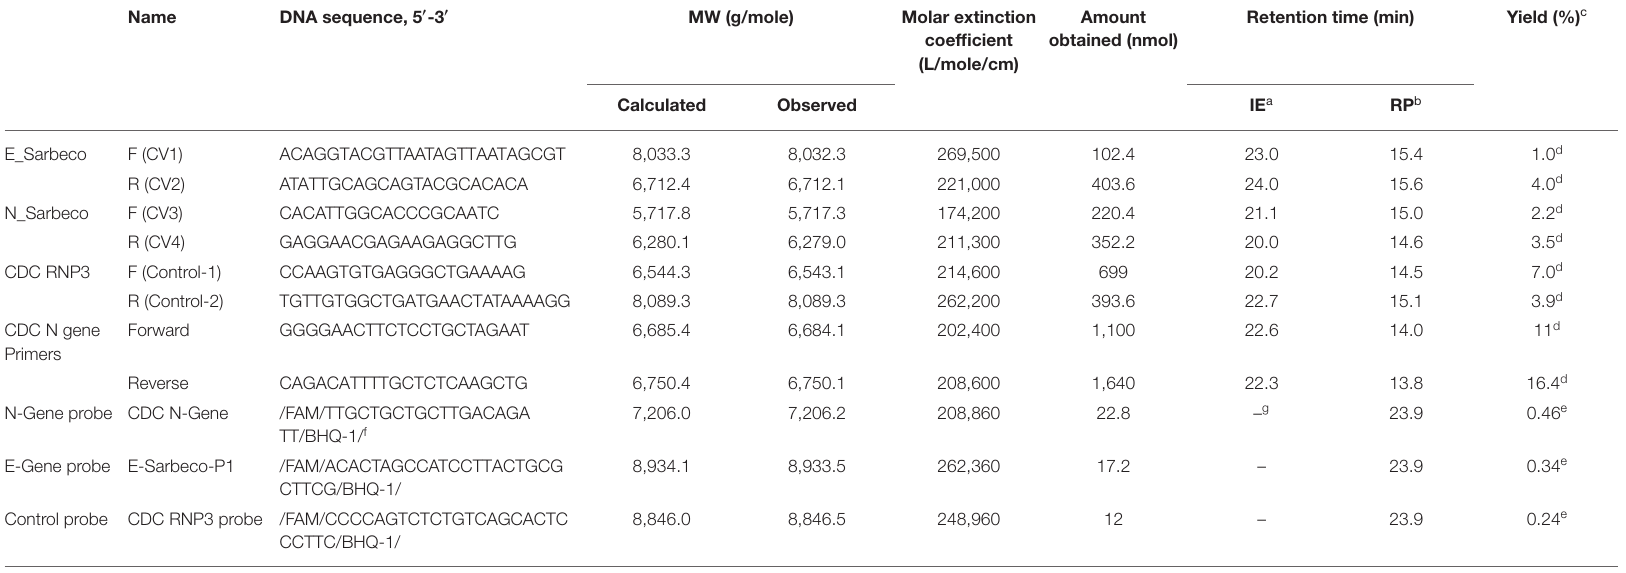
TABLE 1 | List of DNA primers and probes